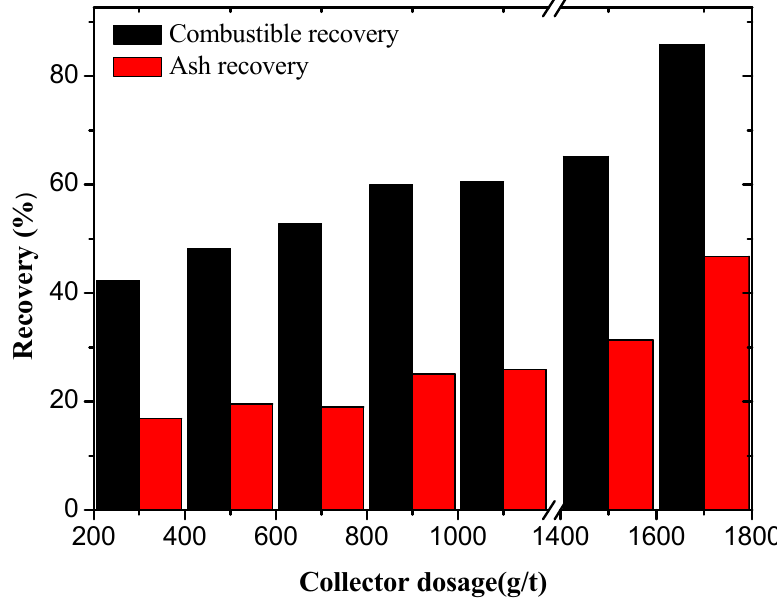
Figure 5. Oxidized coal flotation results using dodecane.